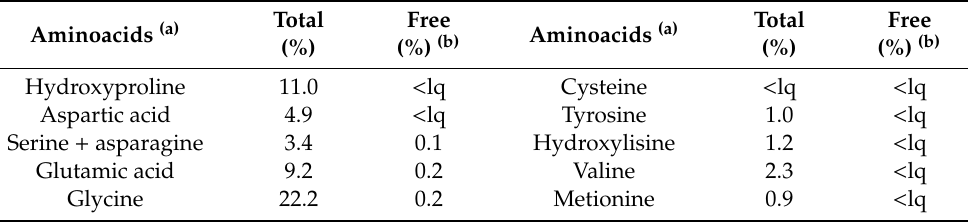
Table 2. Analysis of the aminoacid composition of